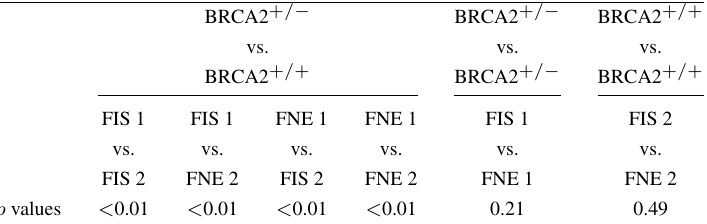
ANOVA statistical analysis of the cell division time of BRCA2 + / + and BRCA2 + / − unmodified primary human fibroblasts BRCA2 + / − BRCA2 + / − BRCA2 + / +